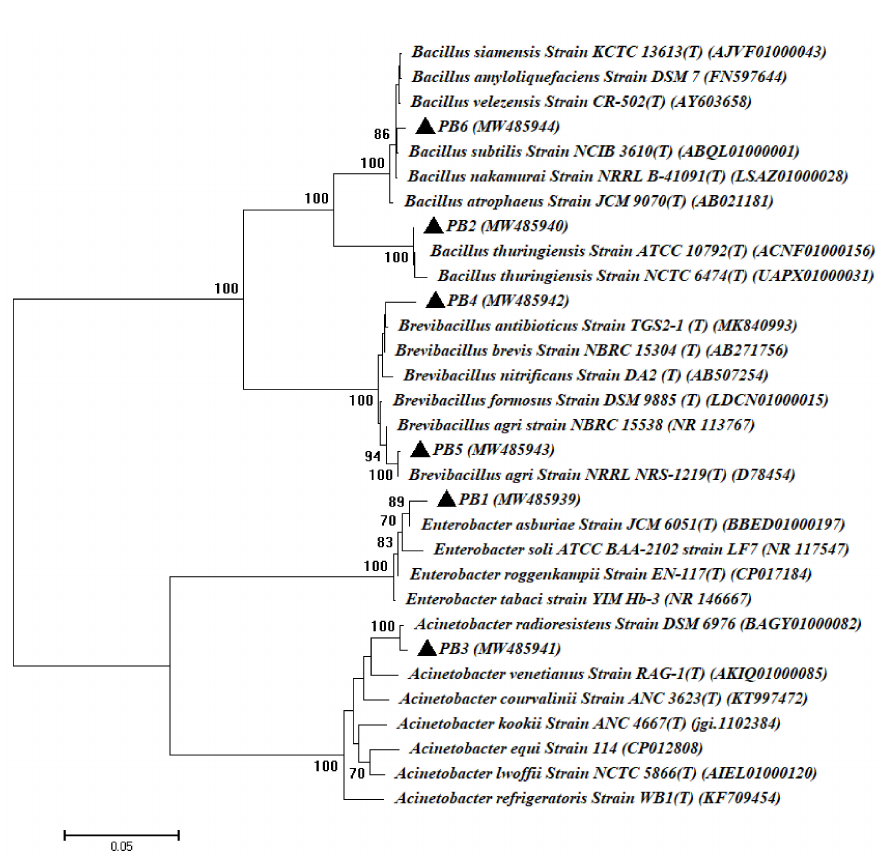
Figure 1. Phylogenetic tree of the 16S rRNA sequences of bacteria isolated from the root of the common bean plant. PB1–PB6 refers to the 16S rRNA sequences of bacterial isolates. The bacterial isolates and their identities were listed in Table 1. MEGA 6 was used to carry out the analysis, which used the neighbor-joining approach with a bootstrap value (1000